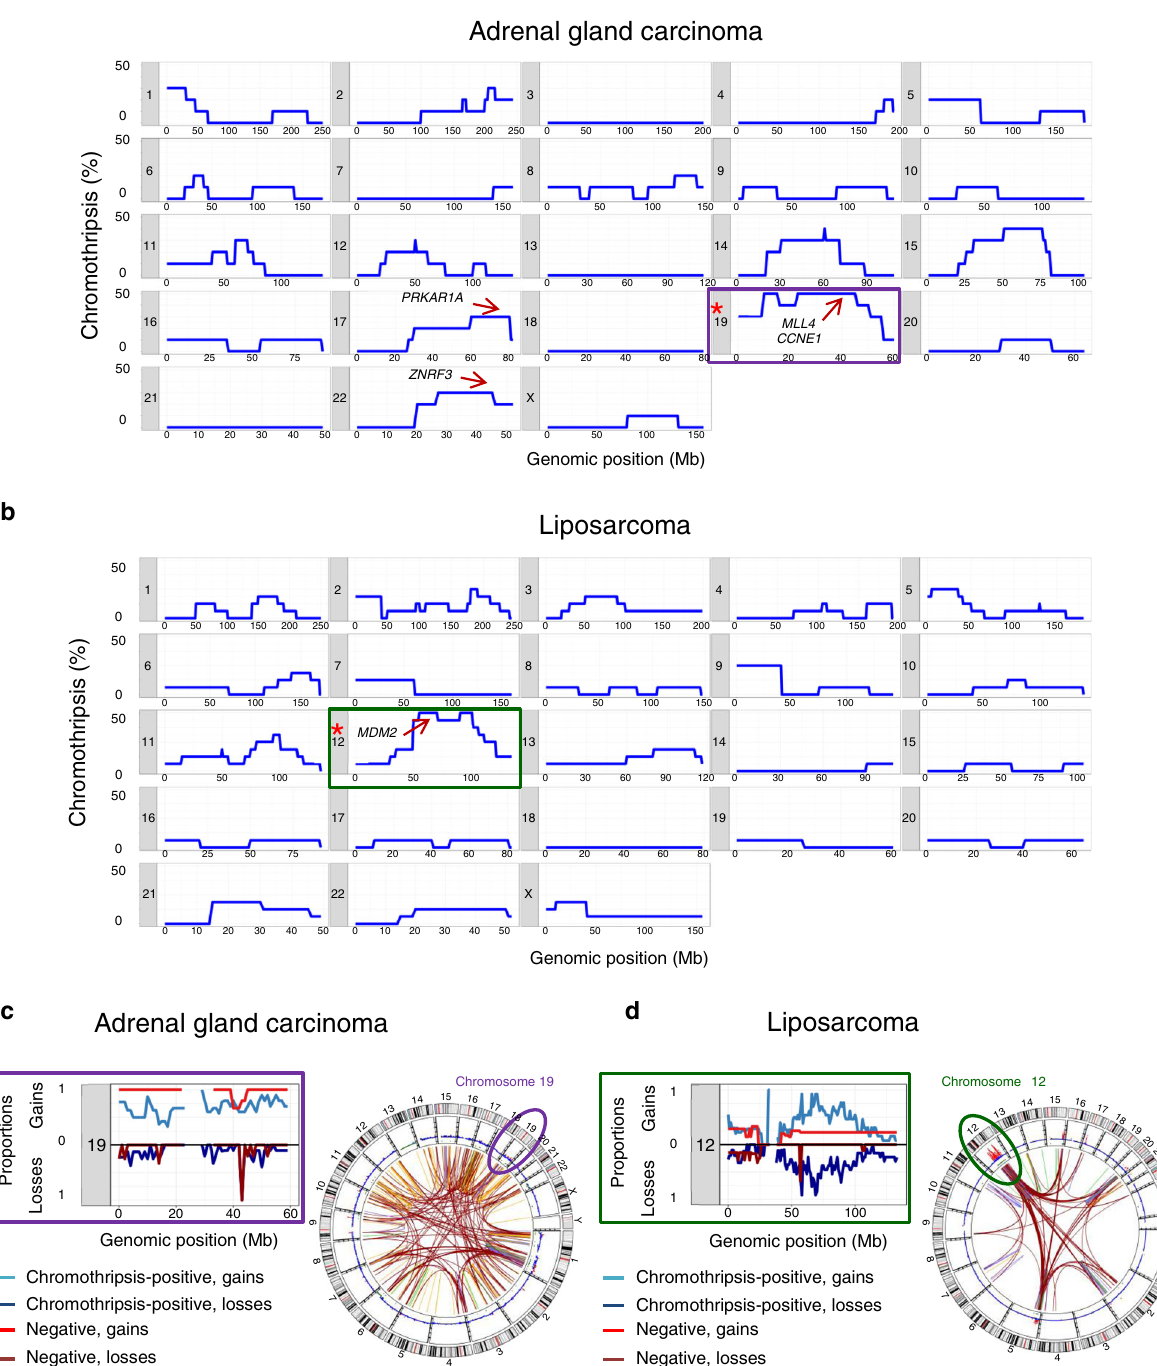
Fig. 3 Frequency of chromothriptic events across chromosomes for two representative tumour entities. a adrenal gland adenocarcinoma, n = 15 cases; b liposarcoma, n = 13 cases, total for high and intermediate con fi dence scoring. The Y axis shows the percentage of chromothriptic events affecting each chromosomal fragment from all chromothriptic cases. Location of known driver genes frequently affected by chromothriptic events is indicated by arrows. Stars indicate chromosomes that are signi fi cantly enriched for chromothriptic events in these tumour entities (permutation test, see also Supplementary data 3). For the frequencies of chromothriptic events on all chromosomes in other tumour entities, please refer to Supplementary Fig. 3. c , d Proportions of gains (upper panels) and losses (lower panels) in tumours with chromothripsis (blue) or without chromothripsis (red) for representative chromosomes frequently affected by chromothripsis, with one illustrative CIRCOS plot for each tumour entity. Lines on CIRCOS plots show deletions in green, translocations in brown, duplications in orange and inversions in